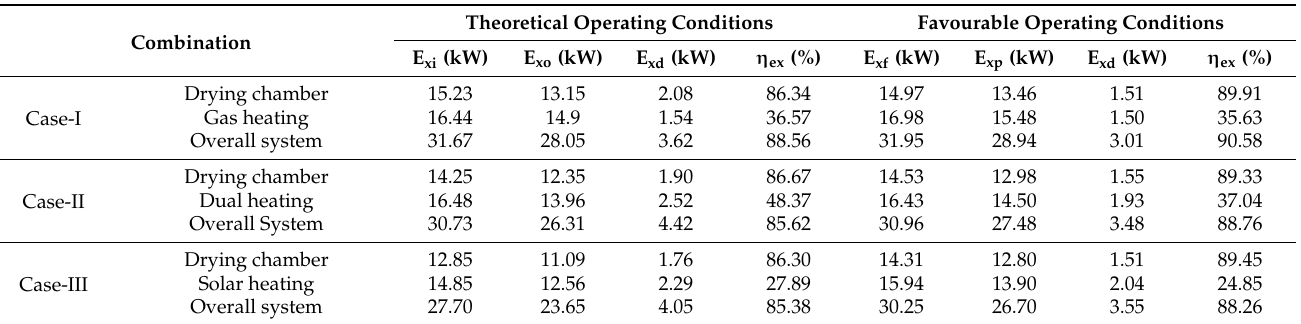
Table 5. Outcomes of exergy analysis under theoretical and optimized (used for unavoidable irre- versibilities) operating conditions.